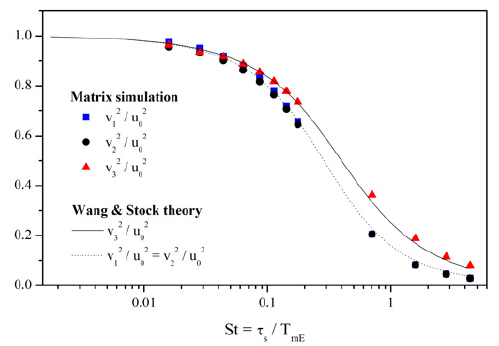
Figure 24. Normalized variance of particle velocity (g ≠ 0).